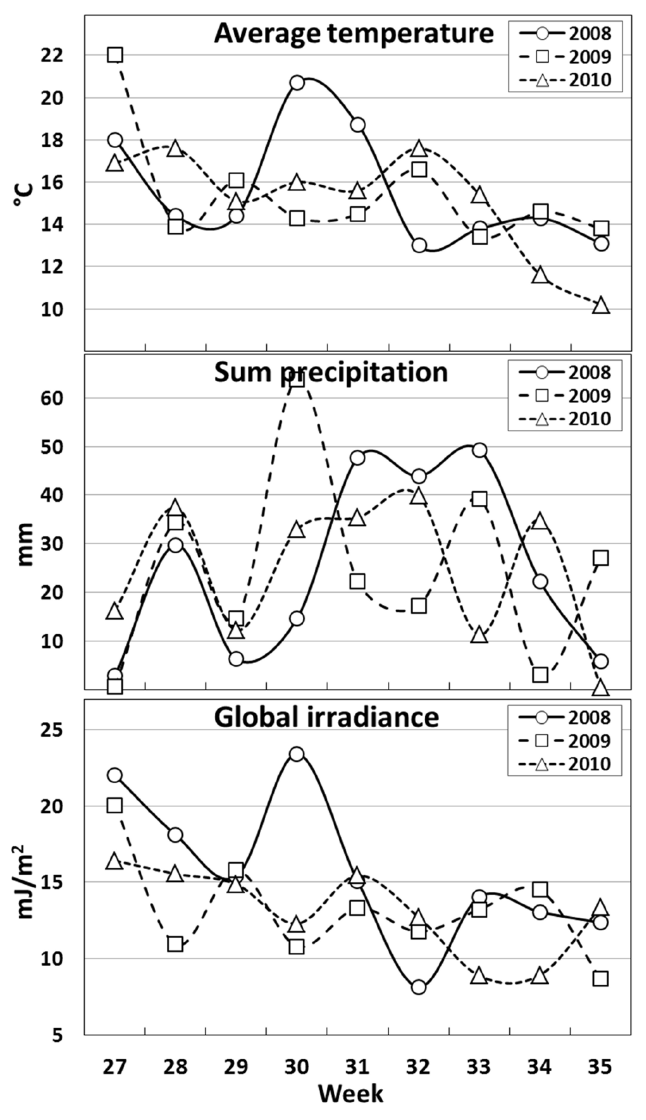
Supplementary Fig. S3: Weekly average temperature, precipitation and global irradiance for field F8 (Tveter) in Southern Norway throughout the summer season in July and August (weeks 27 to 35) from 2008 to 2010.